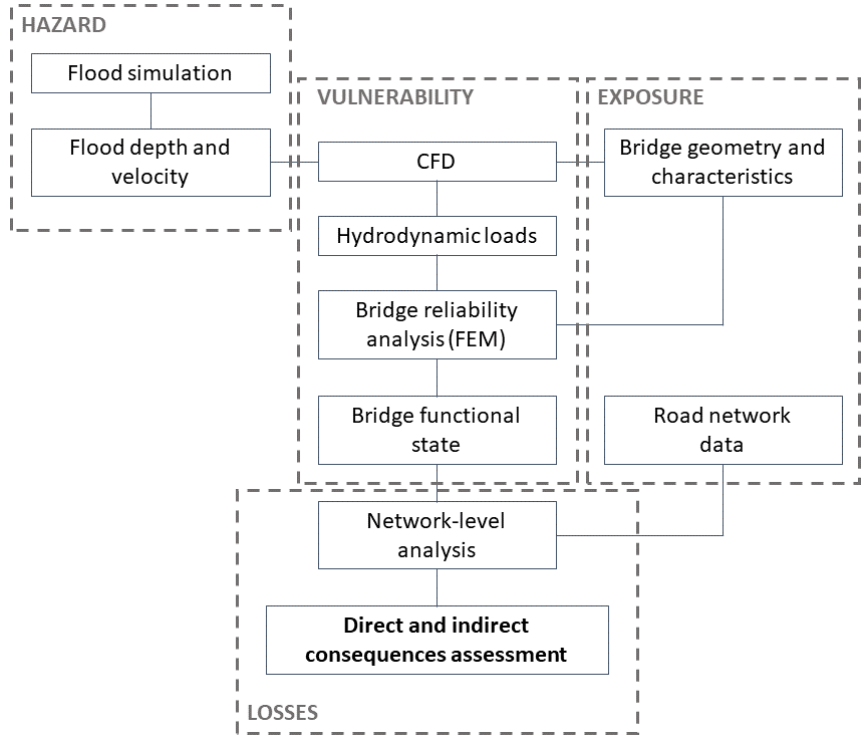
Figure 1. The proposed risk-based methodological flowchart to integrate modeling of hydrodynamic forces, performance and network-level analysis. Abbreviations: CFD – computational fluid dynamics; FEM – finite element model.